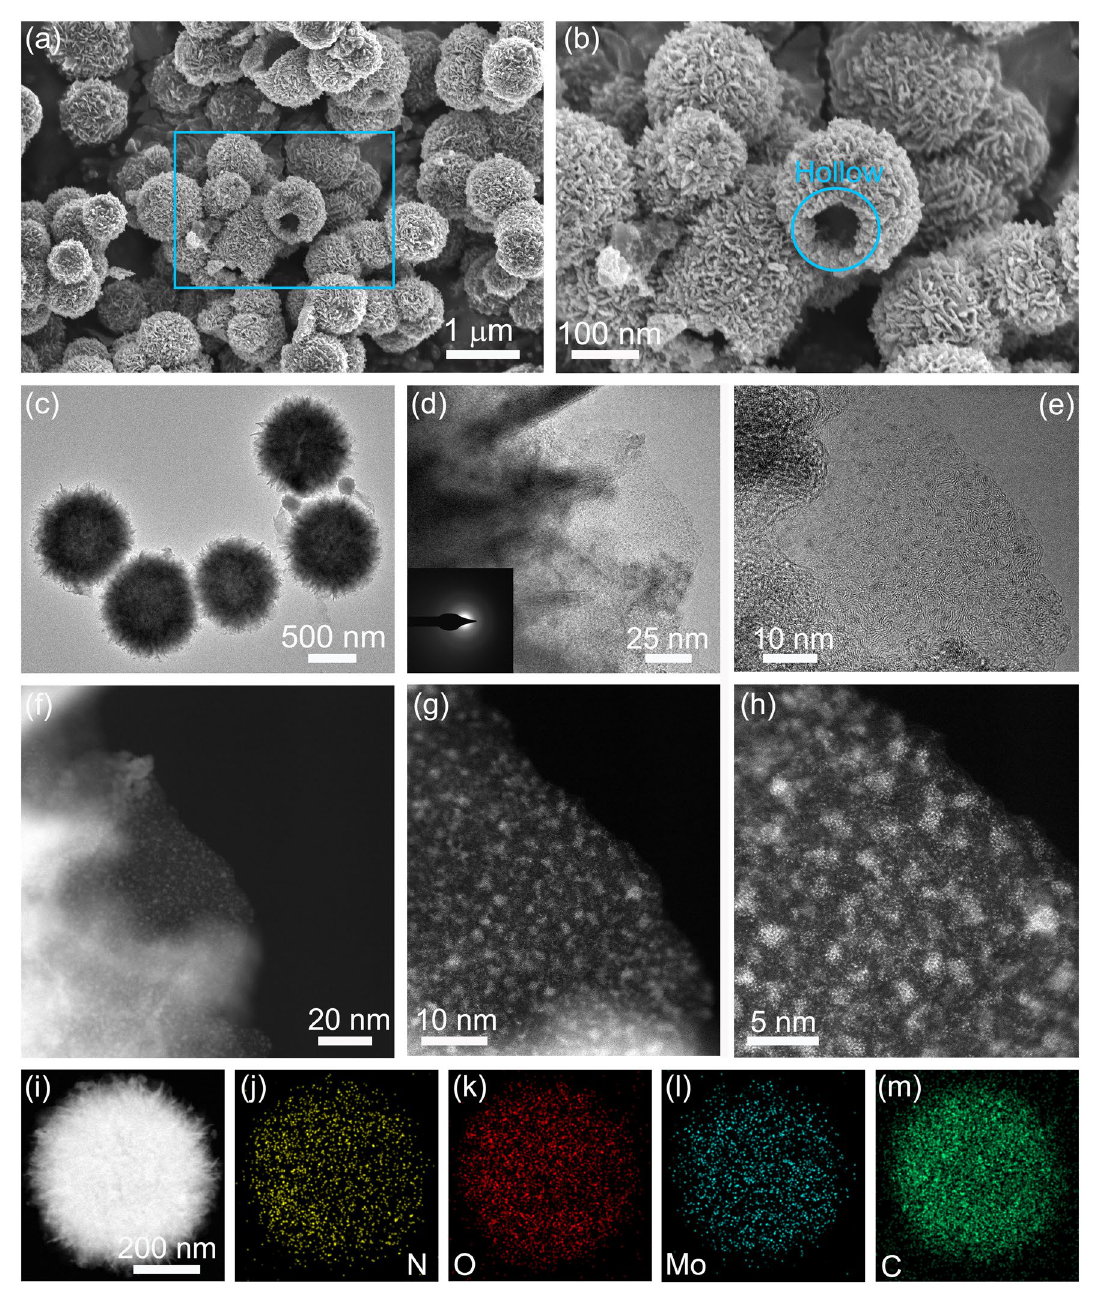
Fig. 2 Morphological and structural characterization of MoO 2.0 N 0.5 /NC. a, b FESEM images. c TEM images. d, e HRTEM images. f–h HAADF-STEM images. i STEM image, and the corresponding EDX mappings of j N, k O, l Mo, and m C. The insert in d is the SAED pattern of MoO 2.0 N 0.5